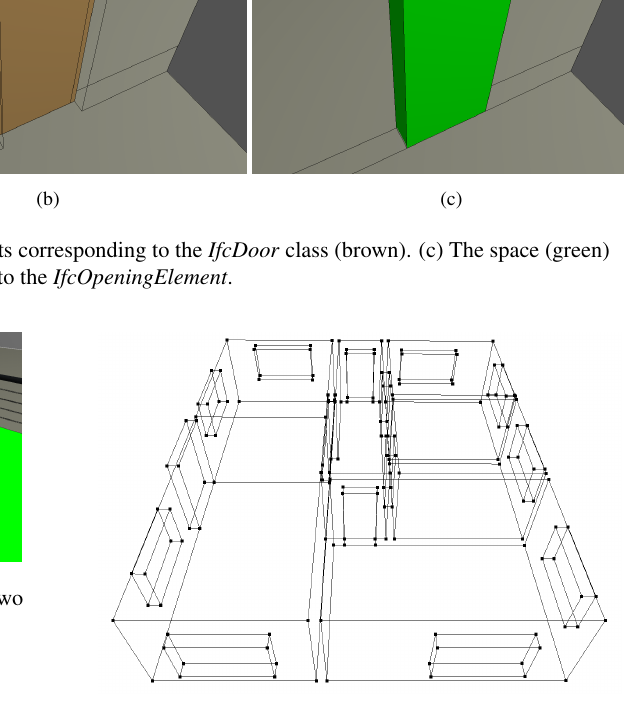
Figure 6. An LCC obtained from an IFC